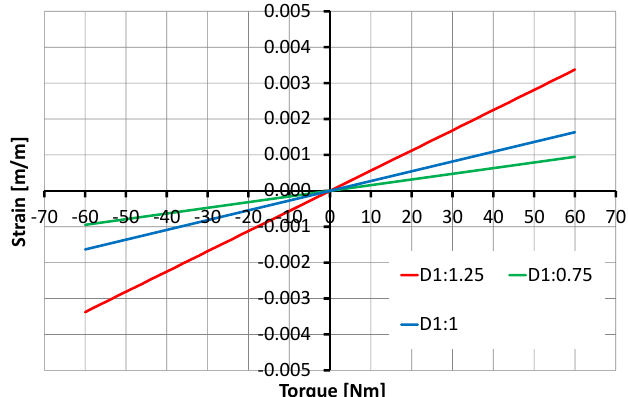
Figure 15. Relationship between the torque and the strain depending on the variation of SCTS’s inner shaft diameter D 1 .